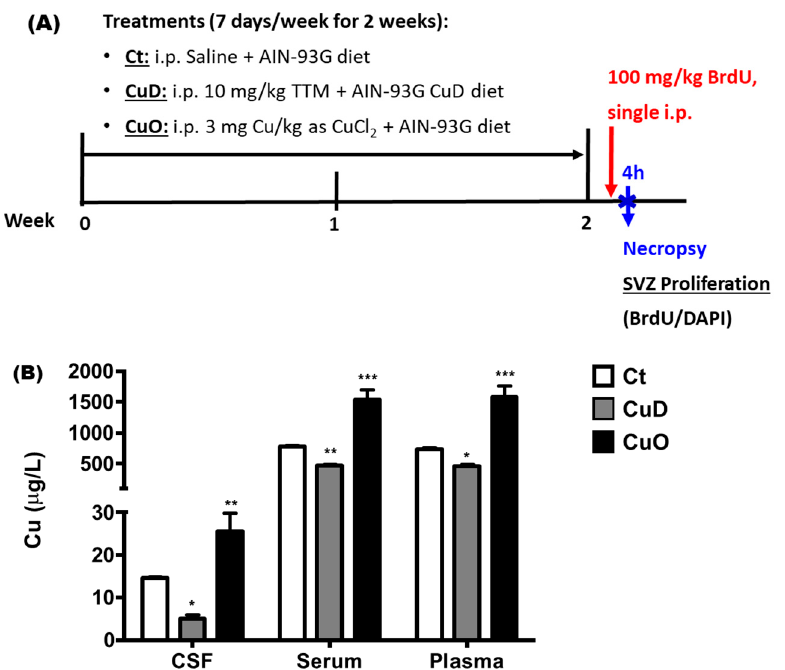
Figure 1. Experimental design and model verification. ( A ). Protocol for 2-week CuD or CuO treatments in rats. Ct: control; CuD: Cu deficiency; CuO: Cu overload. ( B ). Cu concentrations in body fluids. CSF: cerebrospinal fluid. Data represents mean ± SEM, n = 6–7/group. *: p < 0.05, **: p < 0.01, ***: p < 0.001, as compared to the correspondent Ct group, using one-way ANOVA analysis.